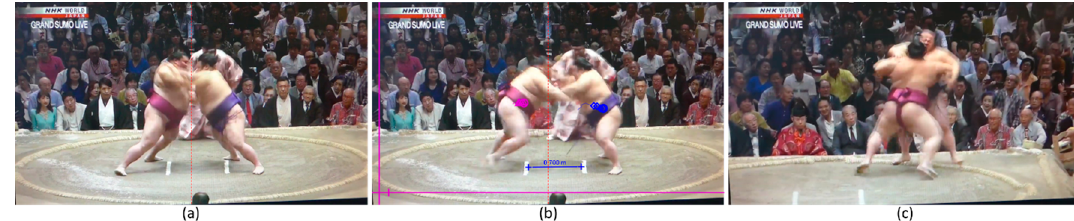
Figure 3. ( a ) Mitakeumi (left) and Takakeish ō (right); ( b ) Mitakeumi had linear momentum to the right, which he needed to get the upper hand on Takakeish ō ; ( c ) Mitakeumi